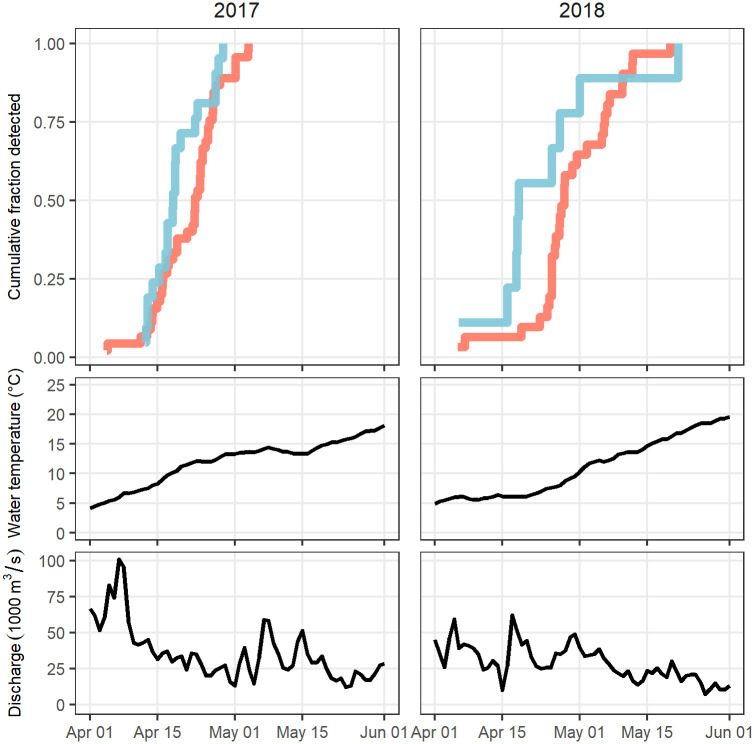
Environmental conditions encountered in 2017 and 2018 by lower (blue) and upper (red) reach contingents.Run contingents were classified according to 2017 returns. Top panels are cumulative frequency distributions on each contingent (lower: blue; upper: red), initiated as they pass Tappan Zee Bridge (river km 43). Monitored water temperature and discharge are daily means derived from Poughkeepsie USGS station data (river km 122).